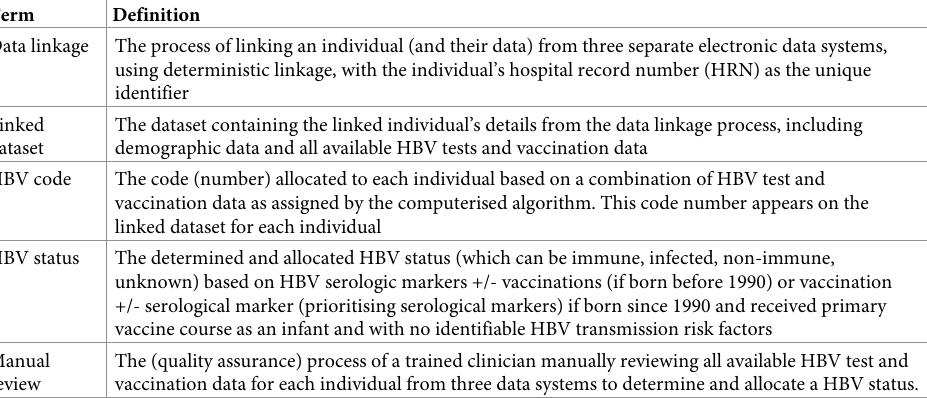
Table 1. Definitions of the terms used for this